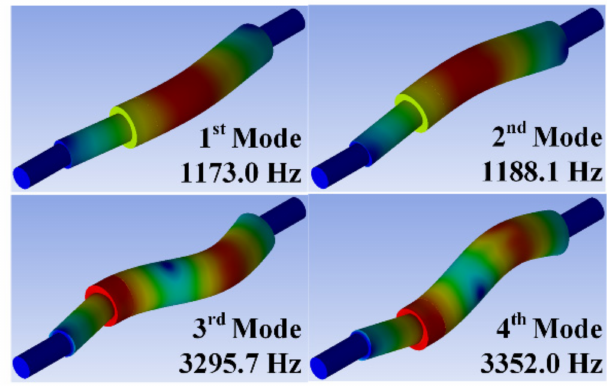
Figure 3. Modal analysis of STS420-J2 shaft